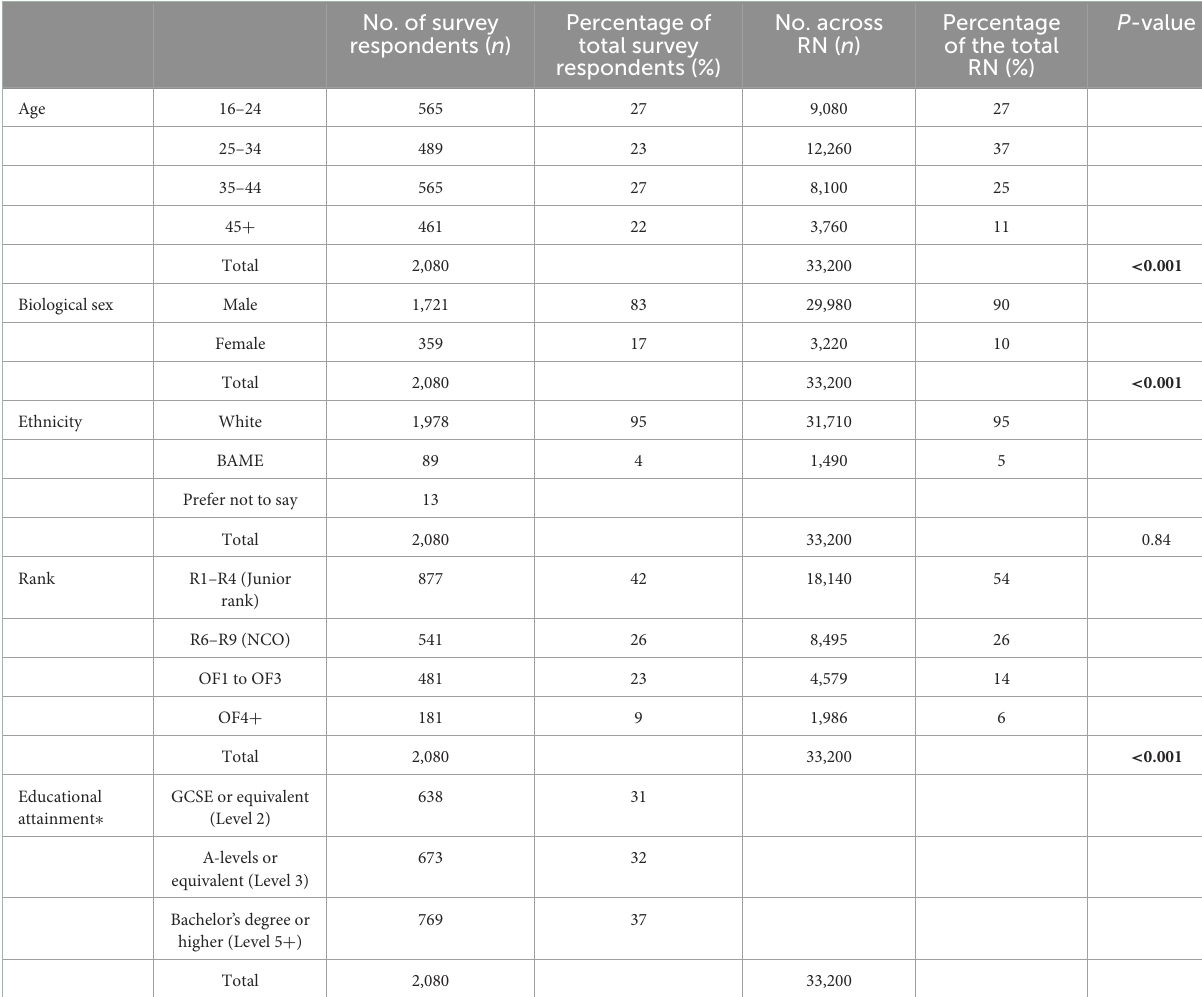
TABLE 1 Summary of demographic responses across the